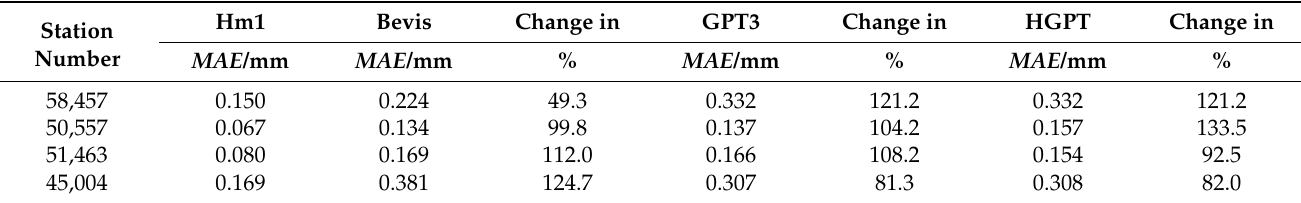
Table 6. The MAE of the differences between the computed and the reference PWV.